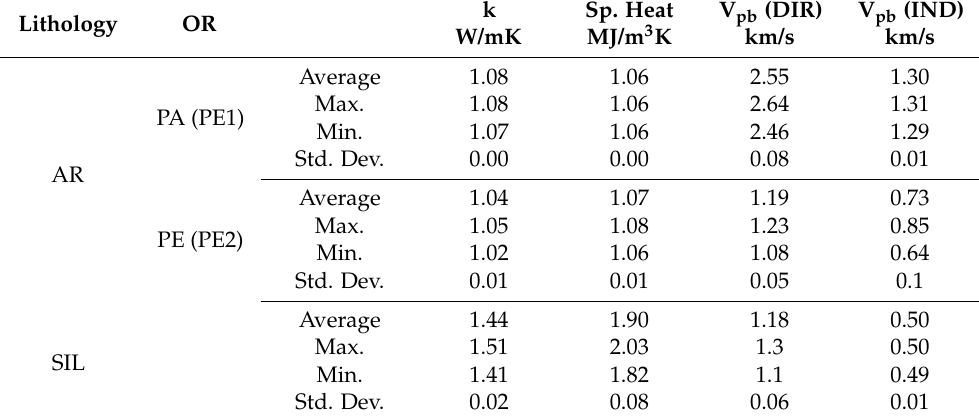
Table 5. Statistical values of the tested thermal and physical properties of block samples for argilla- ceous (AR) and silicified limestone (SIL) samples. OR stands for orientation of test loading direction with respect to the bedding planes. The bedding planes were not present in SIL. Statistics were calcu- lated from 10 readings for 1 test conducted for 1 sample of each lithology. k: thermal conductivity; Sp. Heat: volumetric specific heat; V pb : P-wave velocity measured in rock blocks. OR: Orientation of coring is indicated as PA or PE, orientation of brackets (PE1 or PE2) refers to BTS tests. k Sp. Heat V pb (DIR) V pb (IND) Lithology OR W/mK MJ/m 3 K km/s Average PA (PE1)